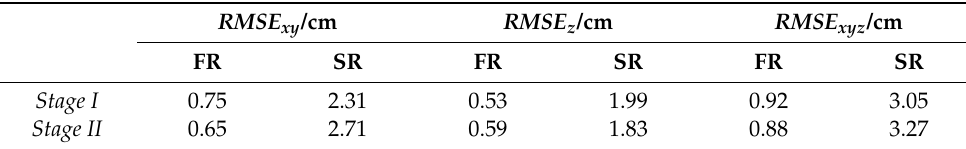
Table 4. The two-stage model quality of the concrete beam.